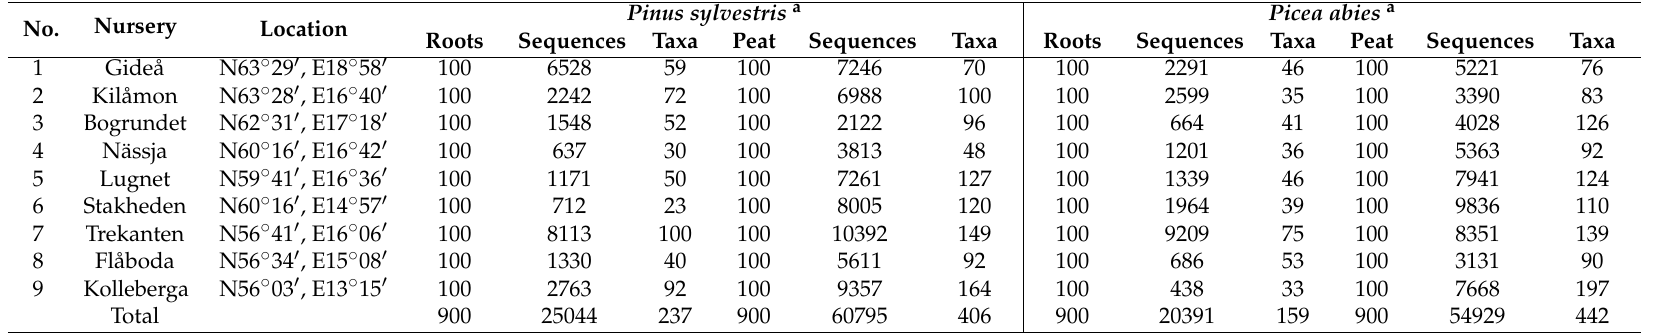
Table 1. Sampled root systems ( roots ) and the sphagnum peat growth substrate of healthy-looking Pinus sylvestris and Picea abies seedlings from nine forest nurseries in Sweden, generated high-quality fungal ITS rDNA sequences using high-throughput 454-sequencing and detected diversity of fungal taxa .